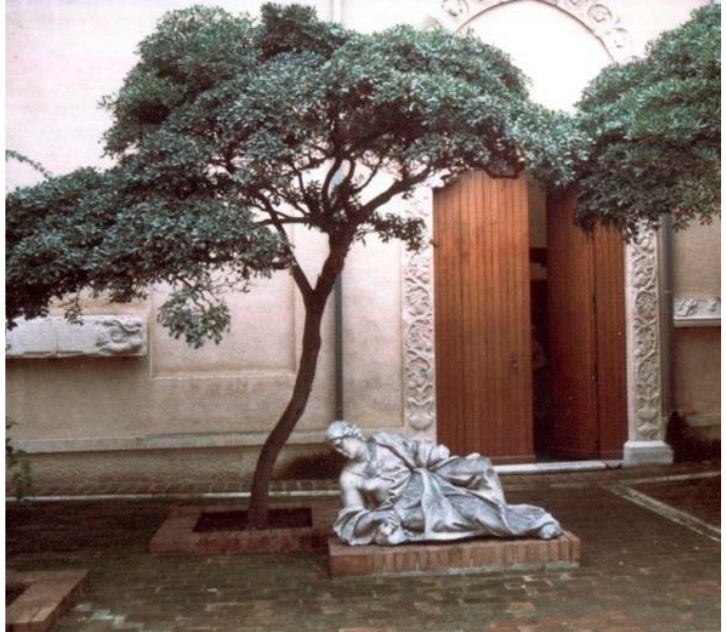
Figure 4. Extended black-greyish patina due to black fungi colonization on marble statue located in the inner yard of the Museum of Messina, Italy, under a tree of Pittosporum tobira. Fungal strains isolated from the statue were attributed to meristematic black fungi and genera of Cladosporium , Alternaria and Phoma Ref. [81].